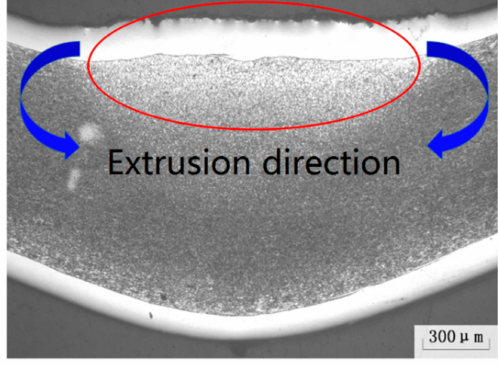
Figure 8. The thickening phenomenon of the SCLP.